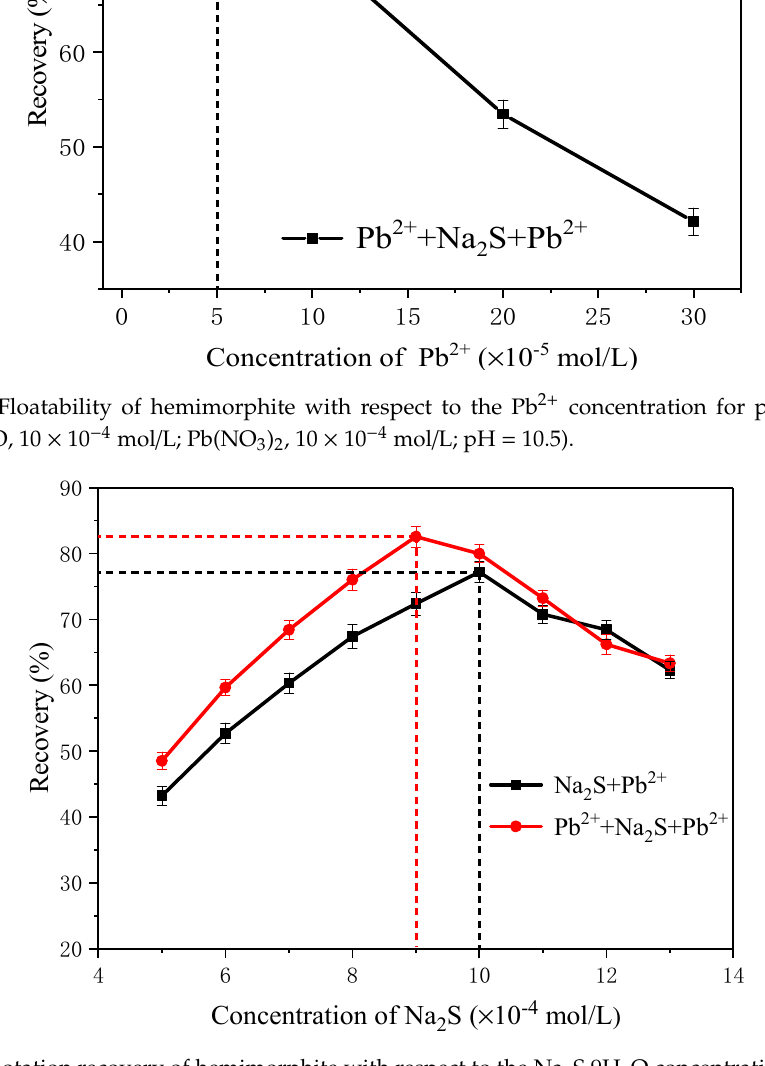
Figure 2. Floatability of hemimorphite with respect to the Pb 2+ concentration for pretreatment (Na 2 S·9H 2 O, 10 × 10 − 4 mol/L; Pb(NO 3 ) 2 , 10 × 10 − 4 mol/L; pH = 10.5).